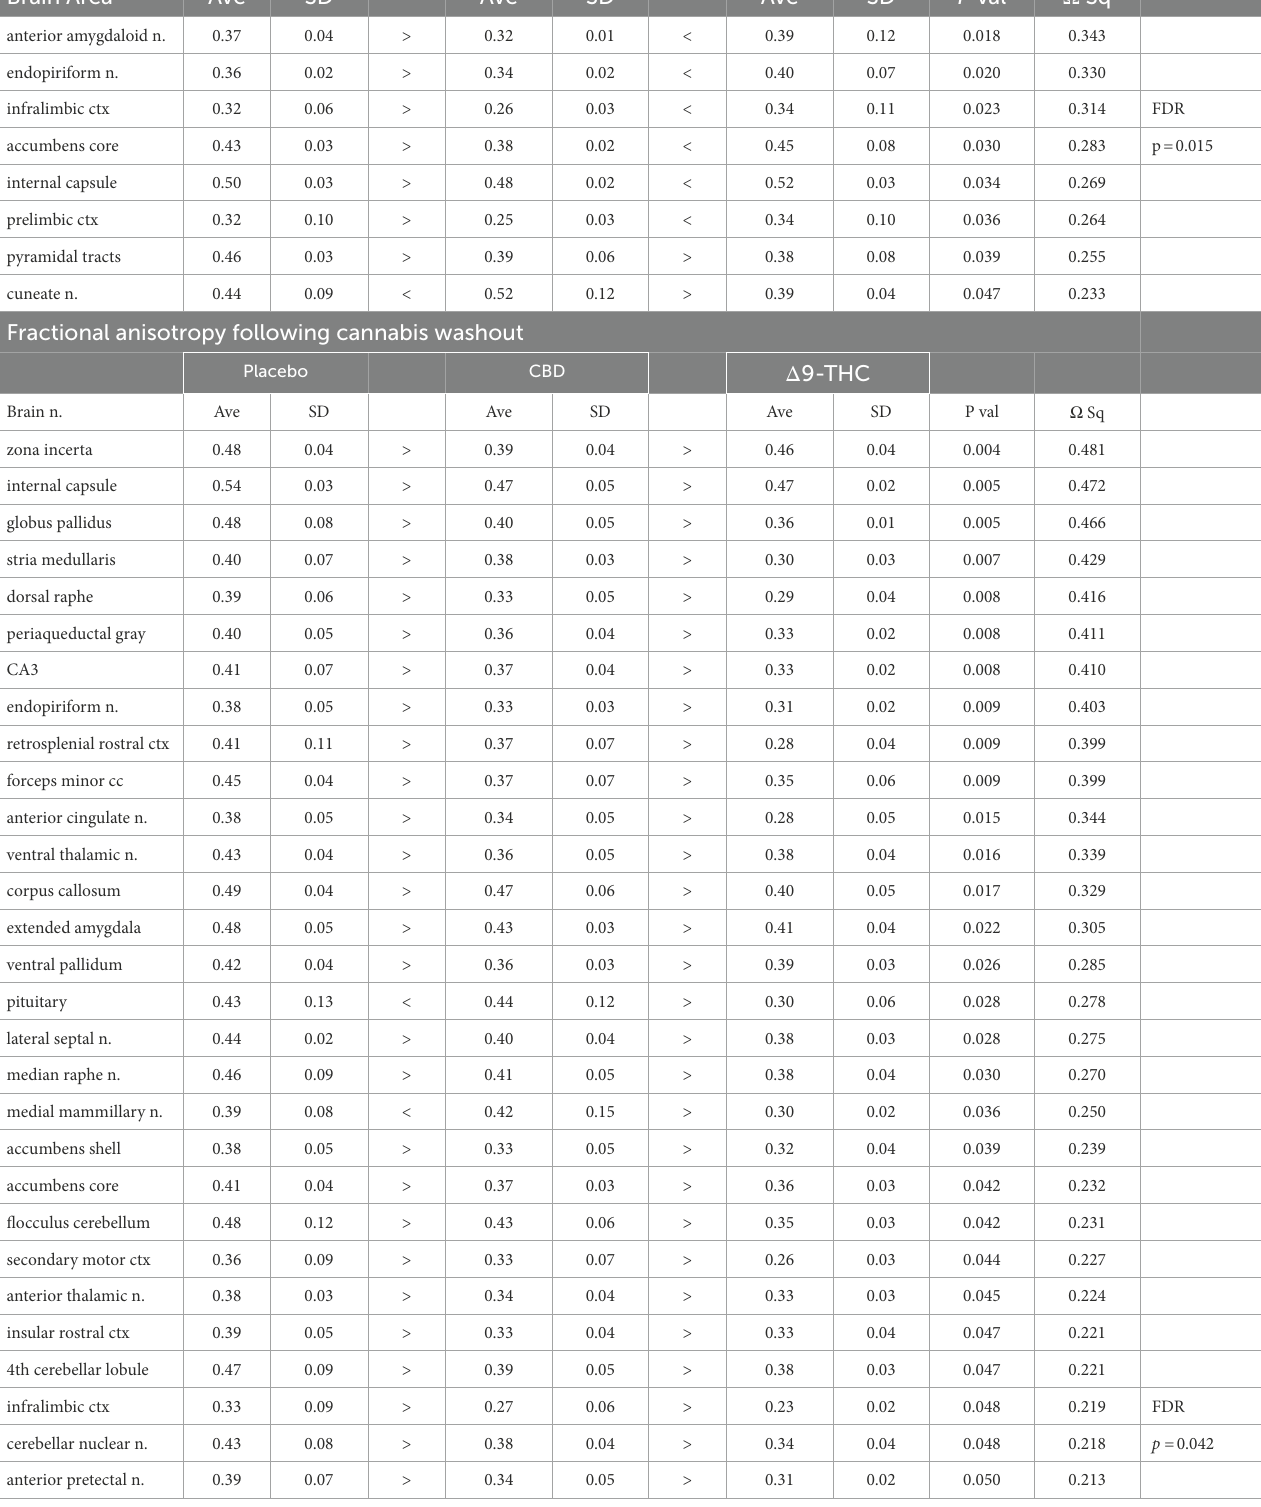
TABLE 2 Fractional anisotropy during and following chronic cannabis exposure. Placebo CBD Δ 9-THC Brain